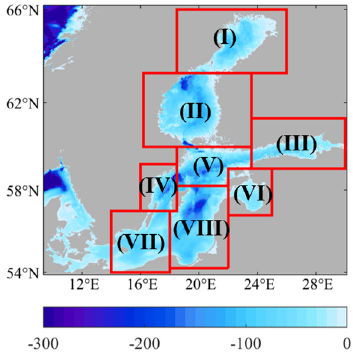
Figure 2. Eight subregions divided in the Baltic Sea, including (I) Bay of Bothnia, (II) Bothnia Sea, (III) Gulf of Finland, (IV) West Gotland Basin, (V) North Baltic Proper, (VI) Gulf of Riga, (VII) Bornholm Basin, (VIII) East Gotland Basin.